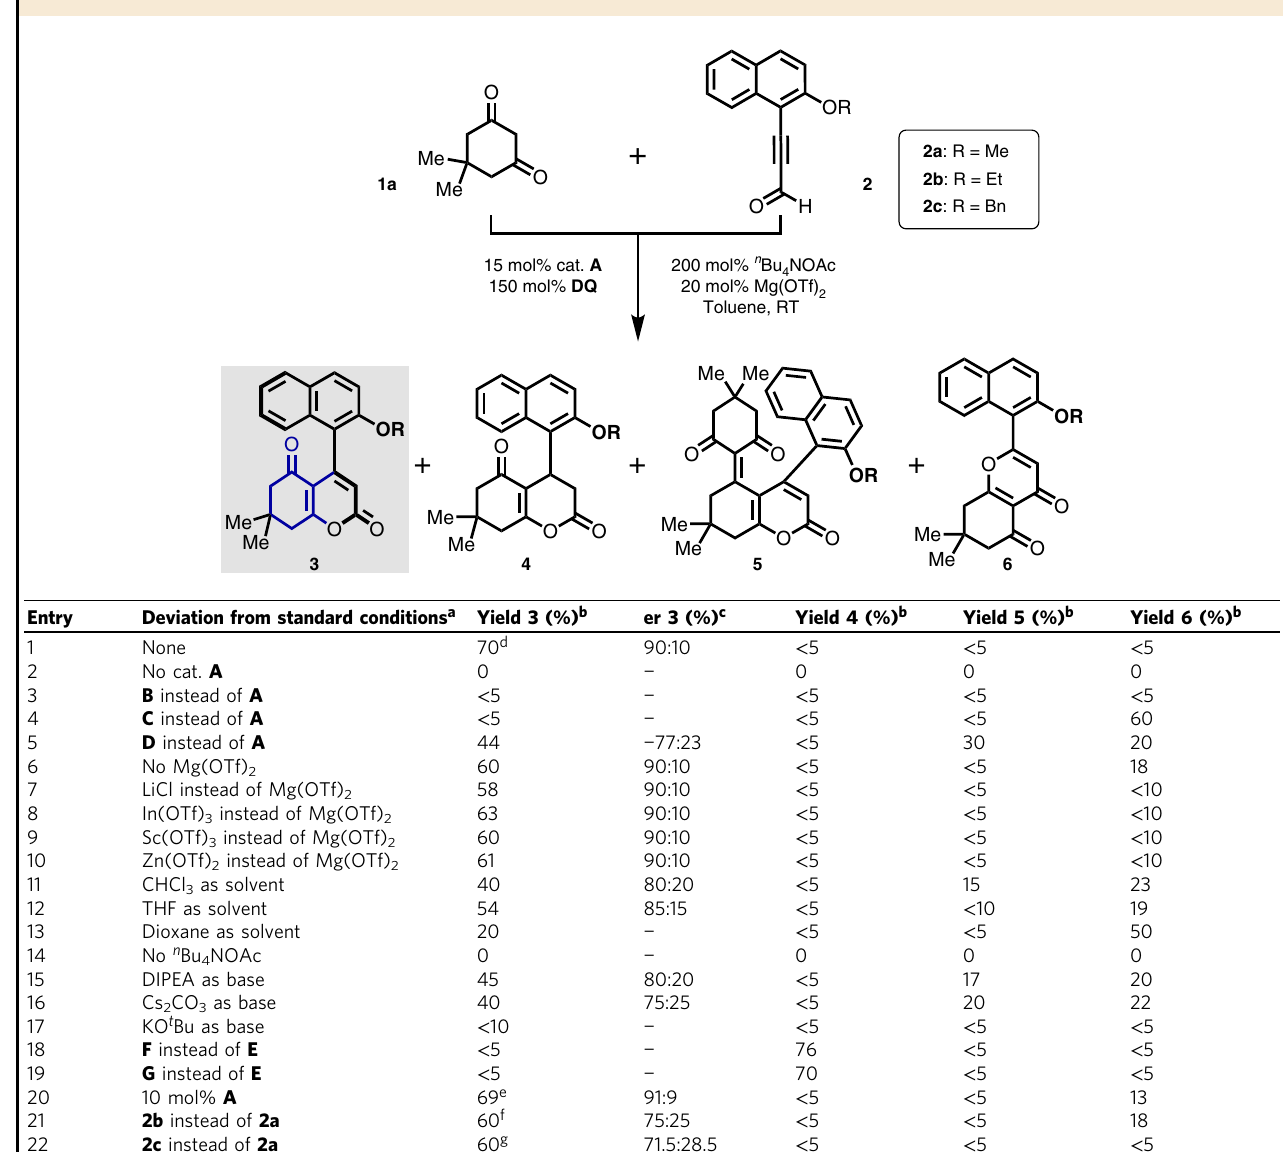
Table 1 Optimization of the reaction conditions